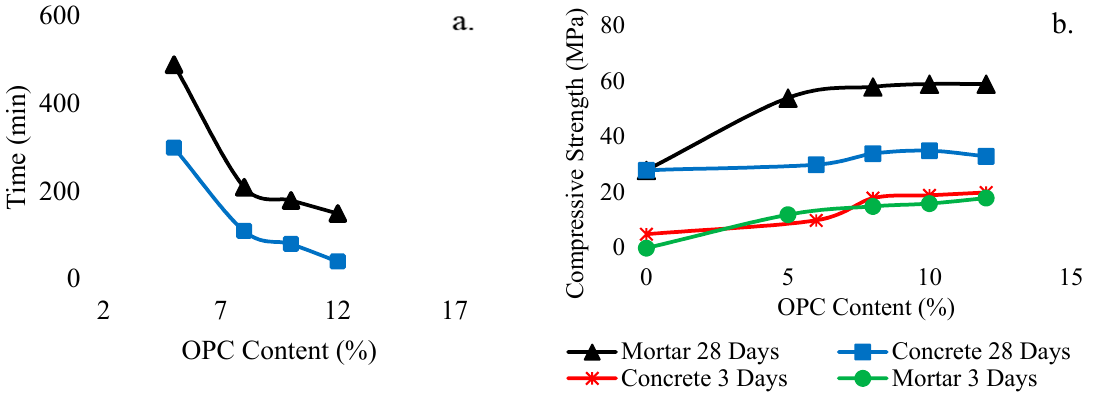
Figure 33. Effect on ( a ) setting time with addition of OPC; ( b ) compressive strength with addition of OPC, modified from [53], Elsevier, 2015.